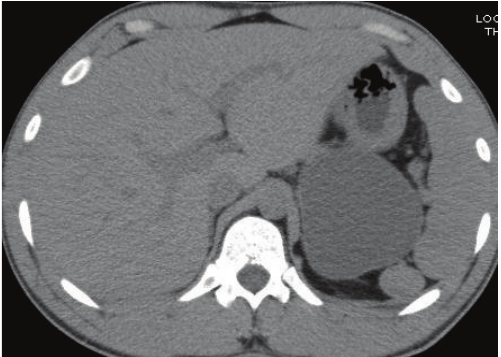
Figure 1: CT scan showing 8 × 7.4 × 6cm homogenous, nonseptated cystic mass posterosuperior to pancreatic tail.